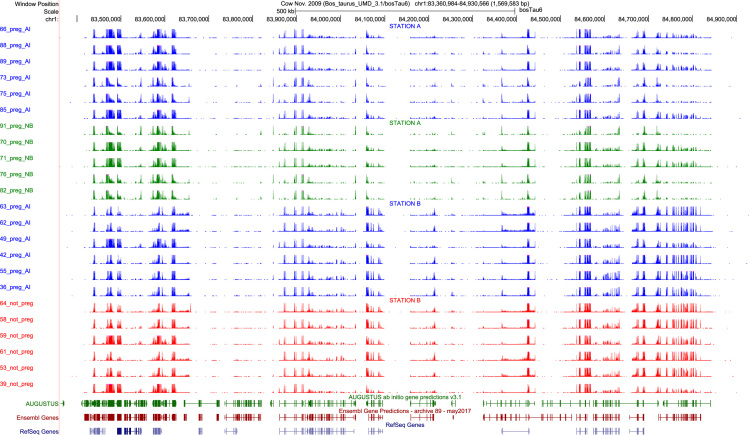
View of the genome browser (Bos taurus UMD 3.1) presenting the normalized coverage created from the RNA-sequencing data. The origin (Station A, B) and group (‘preg_AI’, ‘preg_NB’, ‘not_preg’) of heifers are annotated on the tracks.